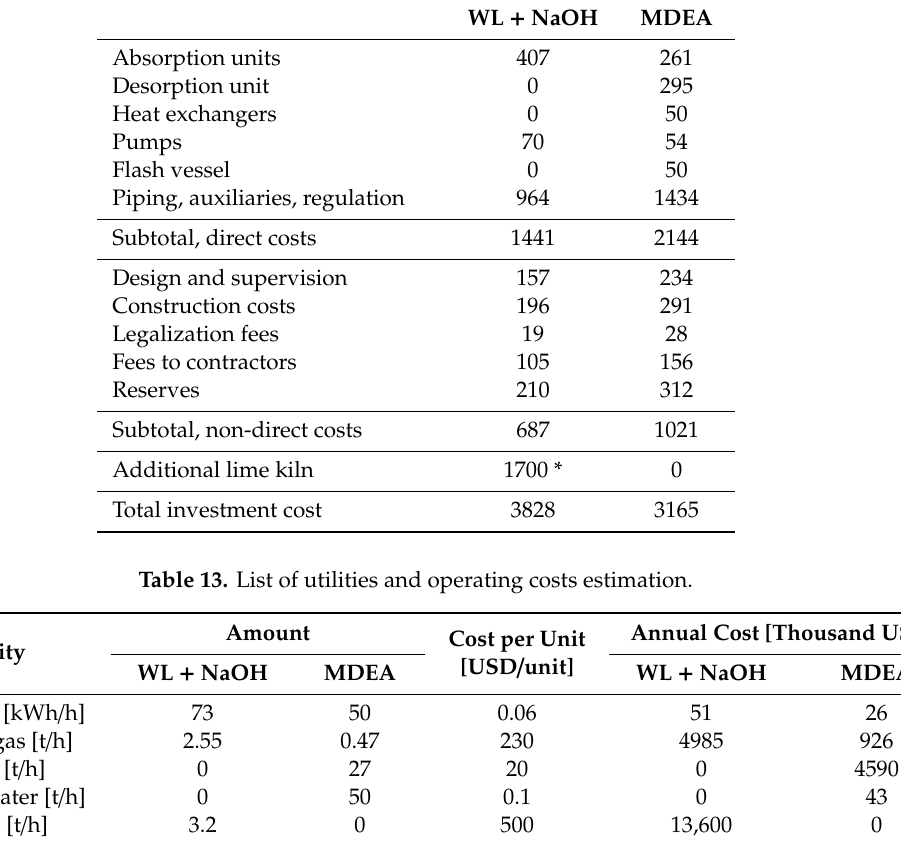
Table 12. Installed capital costs (in thousands USD 2019 ) estimated for white liquor + NaOH and MDEA-based gas cleaning systems. * estimated from Vertical-shaft Limekiln Technology [53].